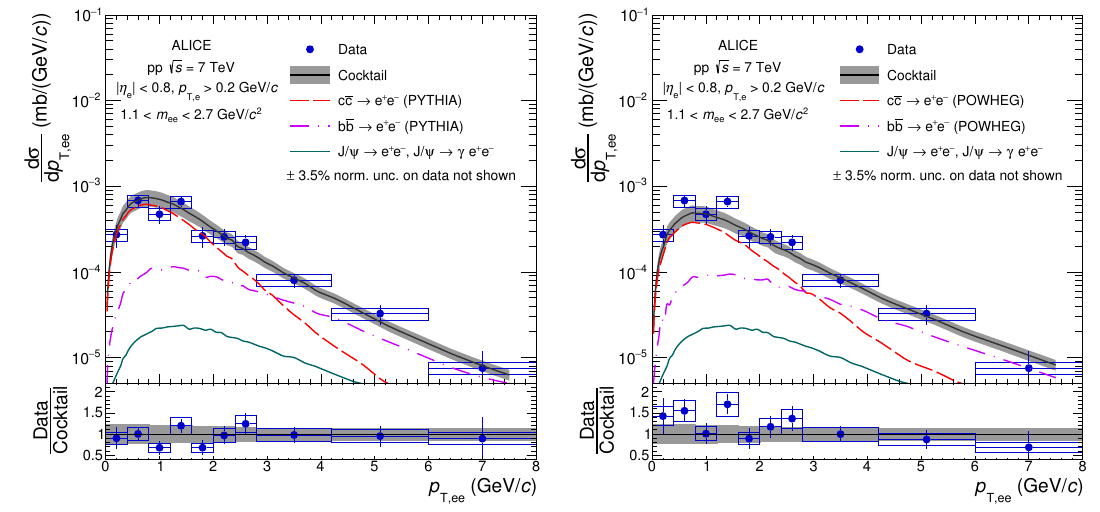
p s = 7 TeV in the